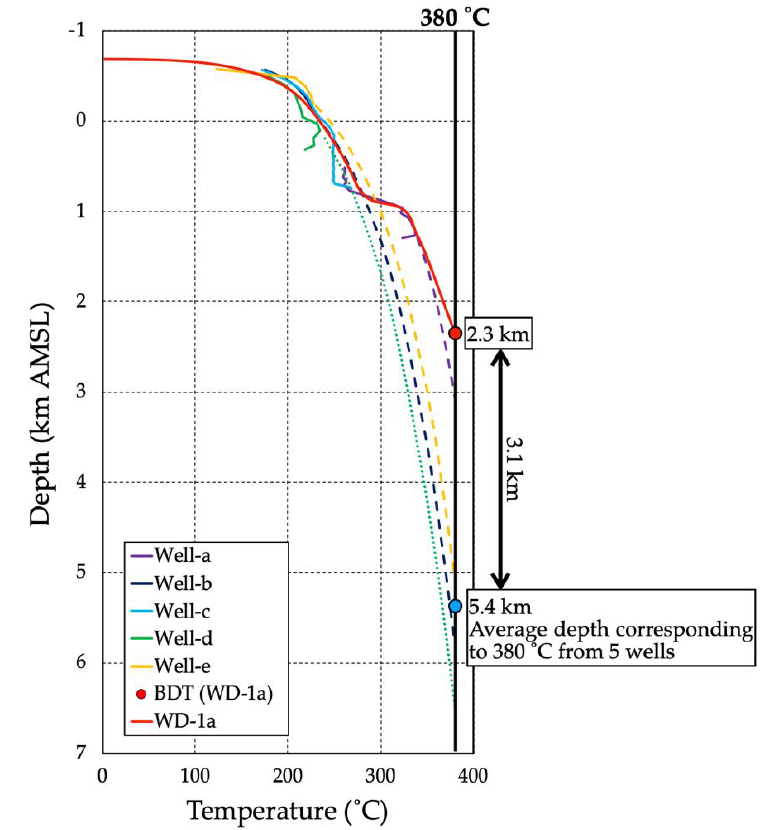
Figure 10. The temperature profile of WD-1a and five neighboring geothermal wells drilled around WD-1a. Solid lines show temperature logging data of geothermal wells. Dotted lines show the temperature curve estimation using the activity index. The blue circle indicates the average estimated depth corresponding to 380 °C using the activity index of five geothermal wells.